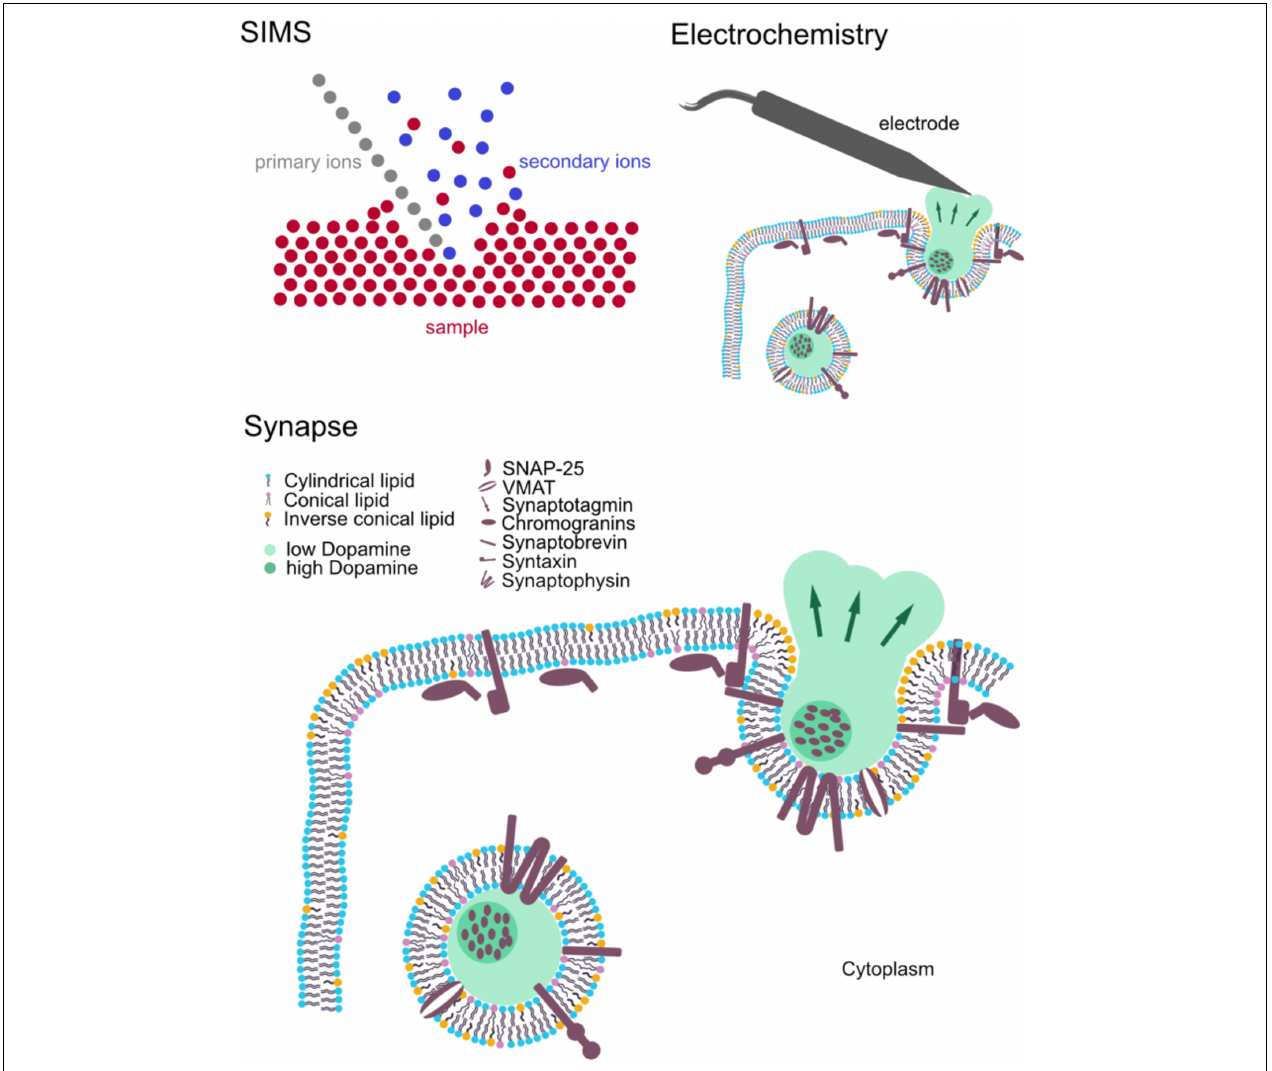
FIGURE 1 | Schematic of the main components of synaptic structure: synaptic vesicles and major associated molecules affecting synaptic activity. Secondary ion mass spectrometry (SIMS) and electrochemistry for measuring synaptic structure and activity,